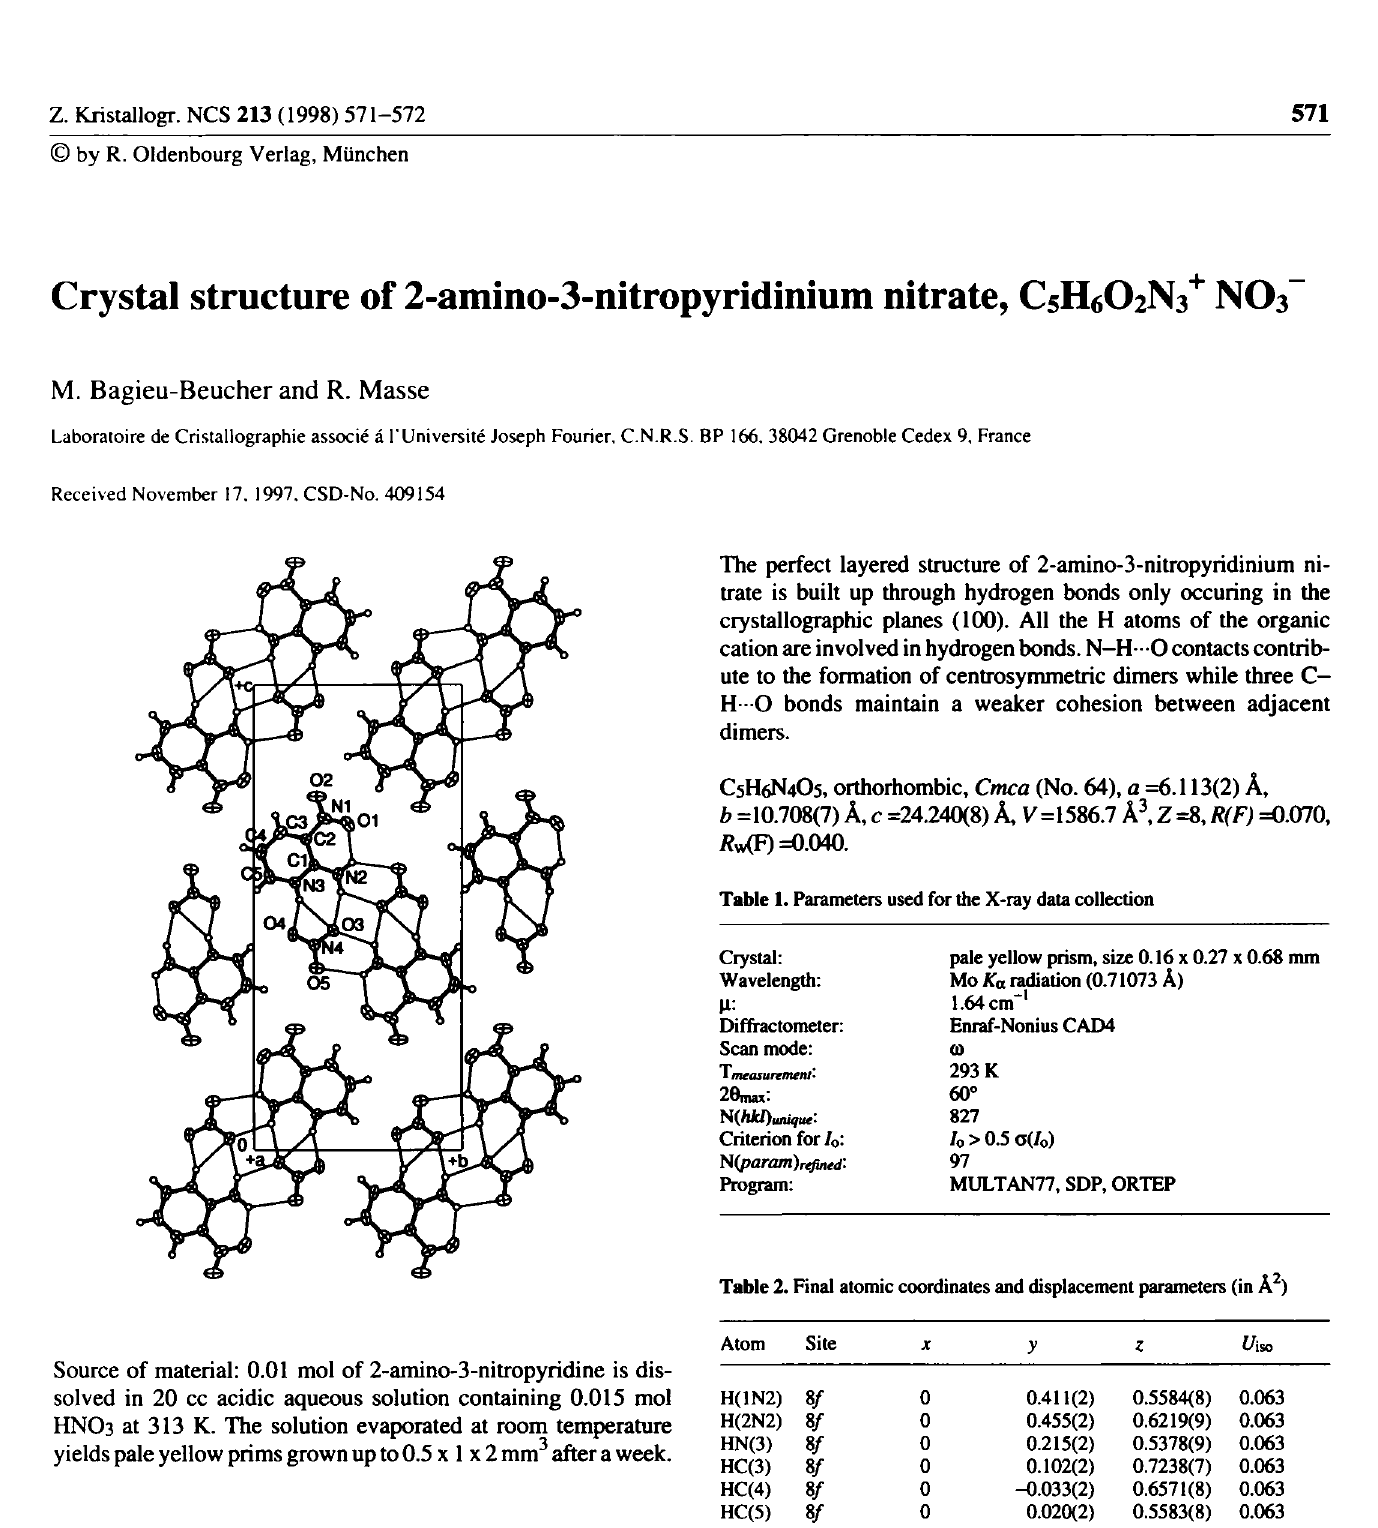
Table 2. Final atomic coordinates and displacement parameters (in Â^)